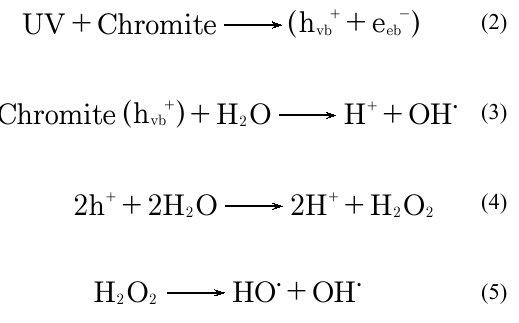
Ni AlCrO (0 ≤ x ≤ 1-x x 4